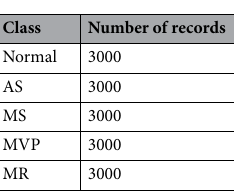
Table 3. The details of the primary dataset after